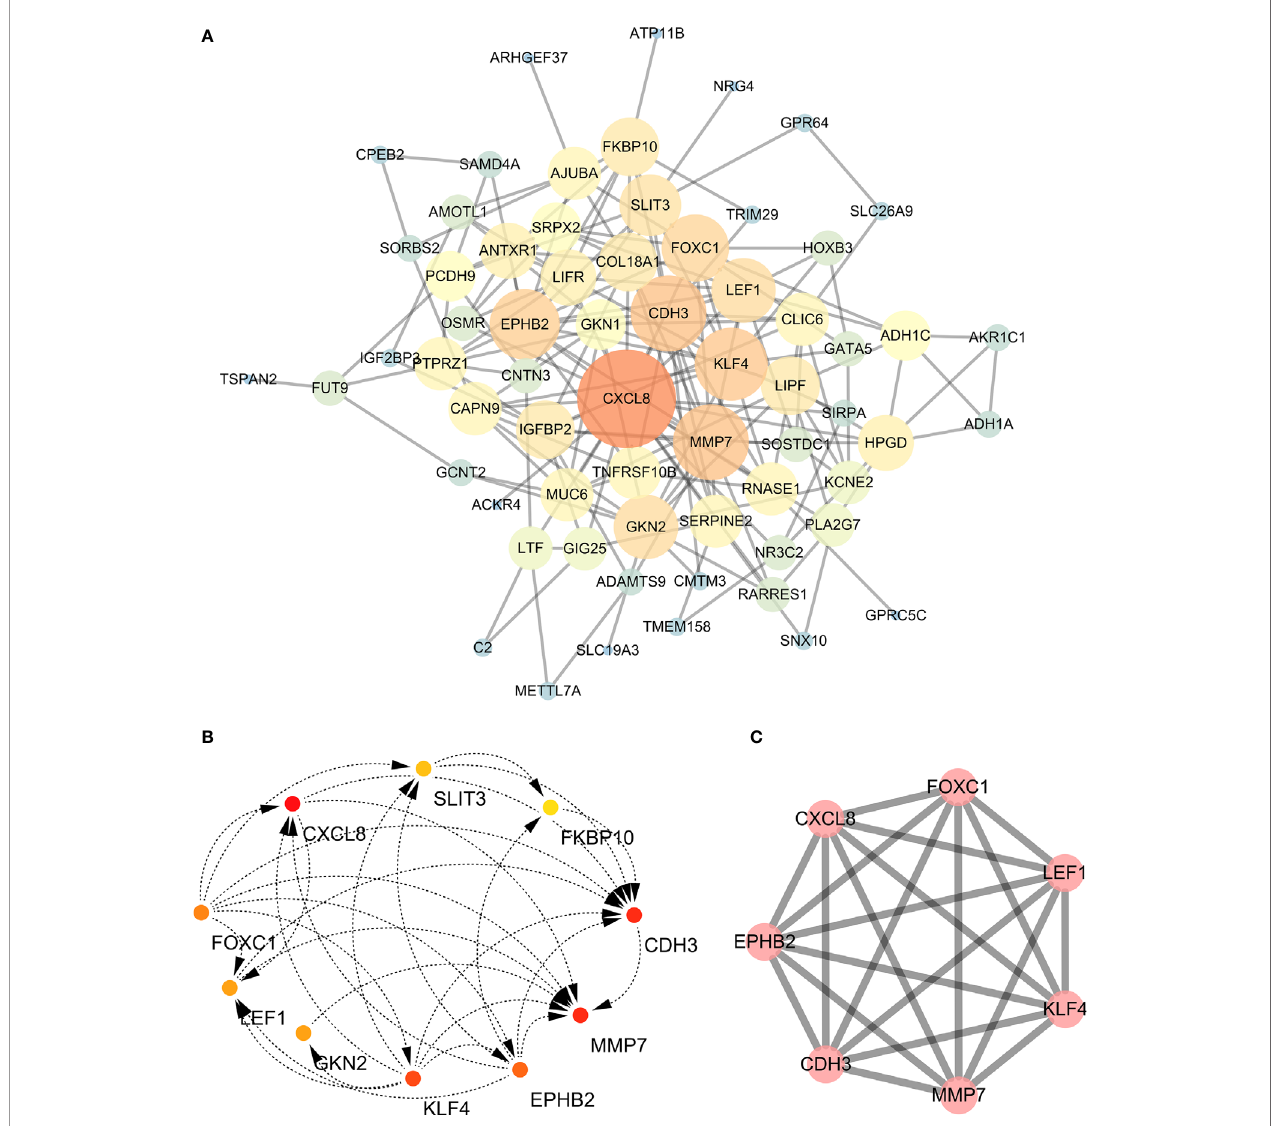
FIGURE 8 | (A) The protein-protein interaction (PPI) network of differentially expressed genes (DEGs). (B, C) The hub genes were identi fi ed from the PPI network and